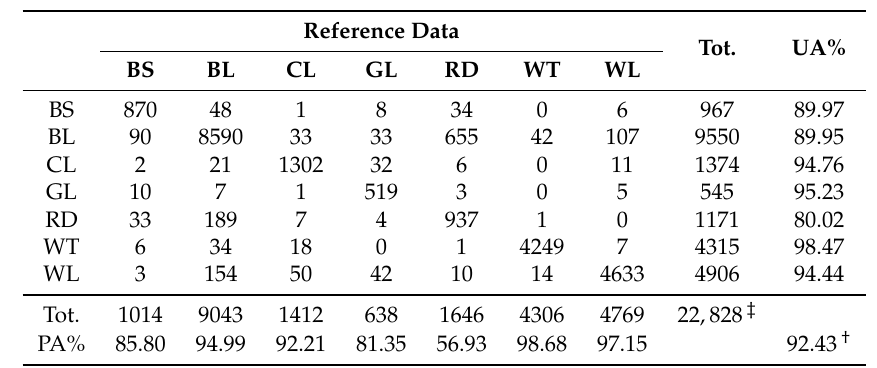
Table 5. Example confusion matrix for 7-class urban land cover classification derived from SPOT-5 image and its spatial information using the Random Forests classifier (Scenario